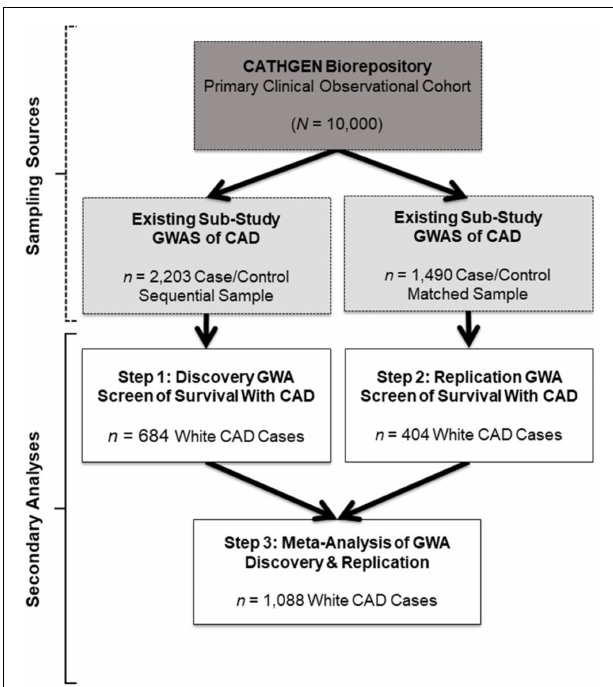
FIGURE 1 | Study design and sample schema. This figure depicts the primary study (dark gray box) and extant sub-study data (light gray boxes) from which our retrospective datasets for the present analyses were derived (white boxes). The CATHGEN Biorepository containing data from 10,000 individuals recruited after cardiac catheterization (dark gray box) supplied the samples for two separate GWASs of CAD sub-studies (light gray boxes), providing the extant GWAS genotype data for our secondary analysis. The first GWAS sub-study contained data from a sequential sample of 2,203 CATHGEN CAD cases and controls (light gray box, left); the other CAD GWAS sub-study had data from 1,490 CATHGEN CAD cases and matched controls (light gray box, right). The white boxes display the secondary datasets we analyzed in the present retrospective study. Specifically, we derived our discovery cohort of 684 White CAD cases (white box, left) from the sequential case-control GWAS data; this discovery dataset was analyzed for Step 1. Our replication cohort of 404 White CAD cases (white box, right) was derived from the matched case-control GWAS dataset; this replication dataset was analyzed for Step 2. We then performed meta-analyses of our discovery and replication cohorts (black arrows converging on the bottom white box) for Step 3.